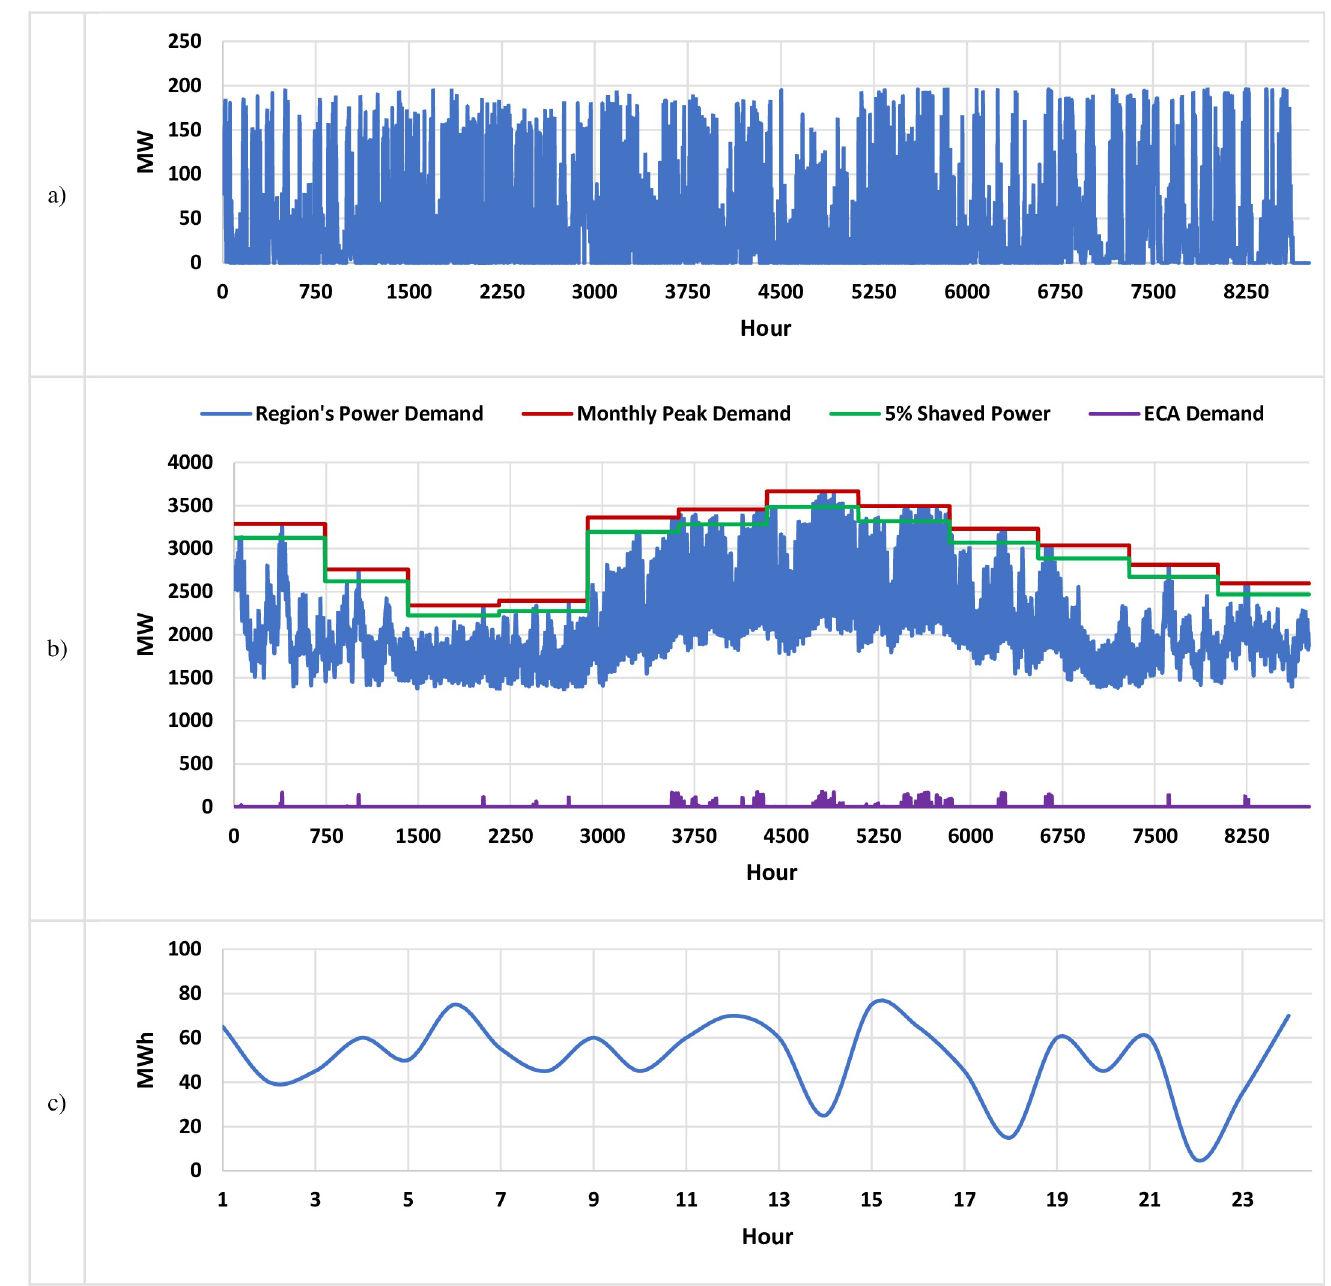
Fig 4. The simulation model’s data inputs. a) The calculated curtailed power available for storage at the Chapman Ranch wind farm (Texas, USA) during 2018 after injecting power to the UG, with the real-time generation estimated based on actual weather data in the region. b) The region’s load demand in 2018 along with 5% monthly peak shaving used for ECA. c) An estimation for the hourly energy demand by the EVCSs which serves a future population of 10k EVs in the region for a typical day